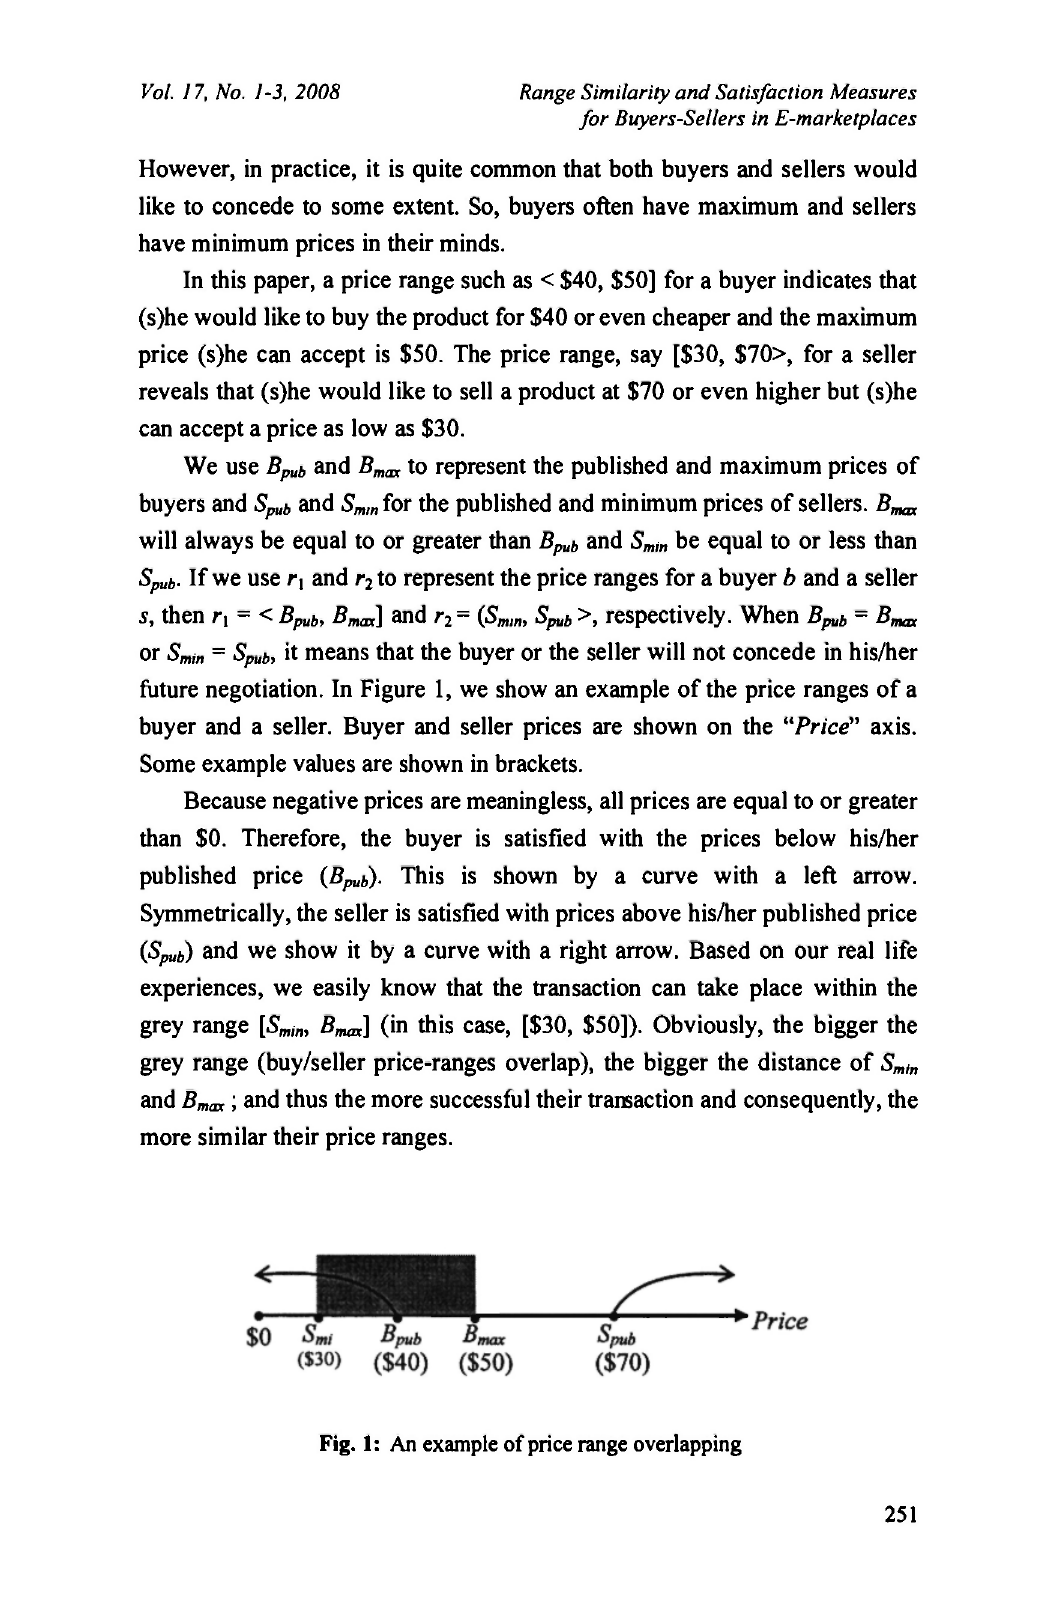
Fig. 1: An example of price range overlapping